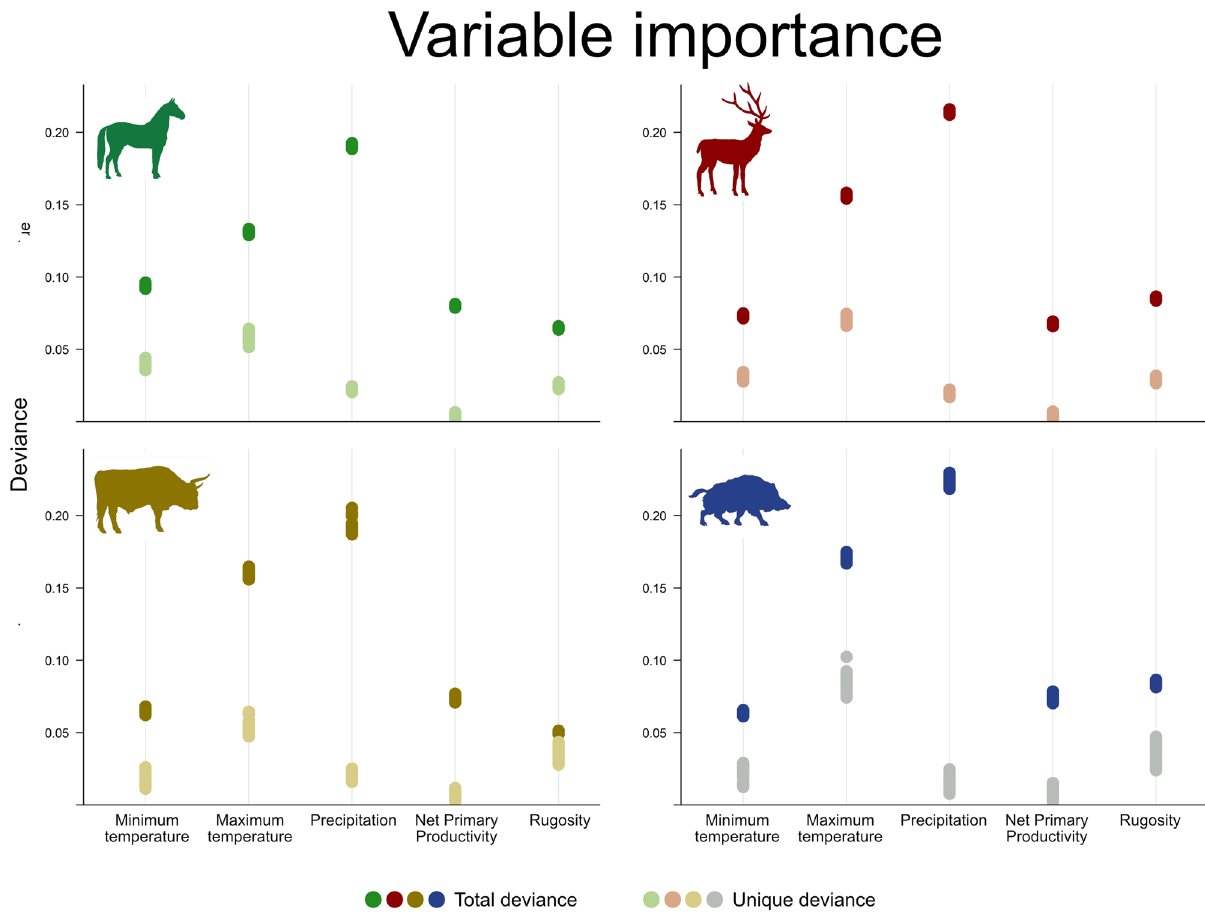
Fig. 3 Variable importance. Calculated both as the unique deviance explained by each variable (lighter points) and its total variance (darker